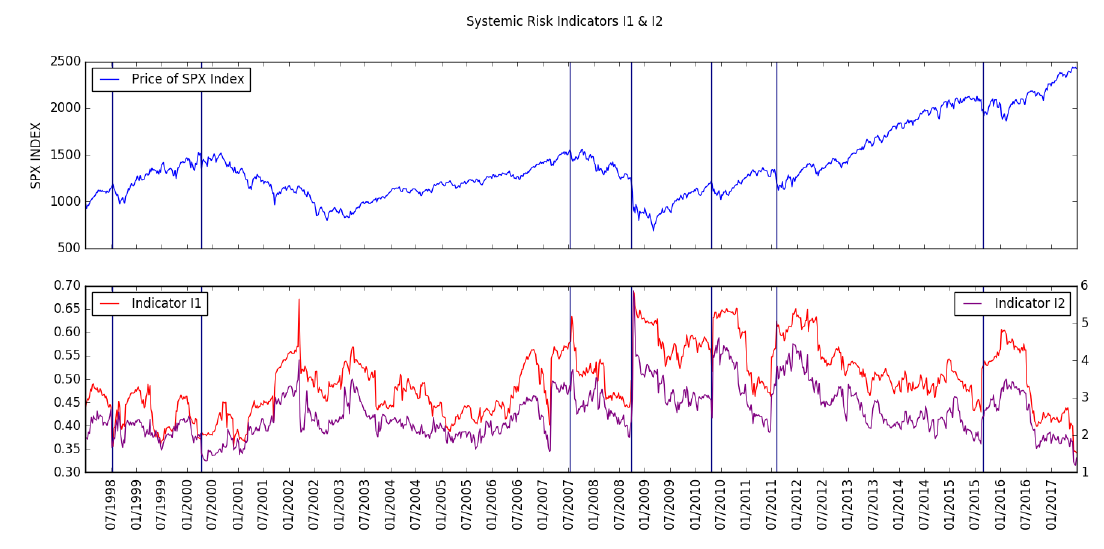
Figure 10. Systemic Risk Indicators I 1 and I 2